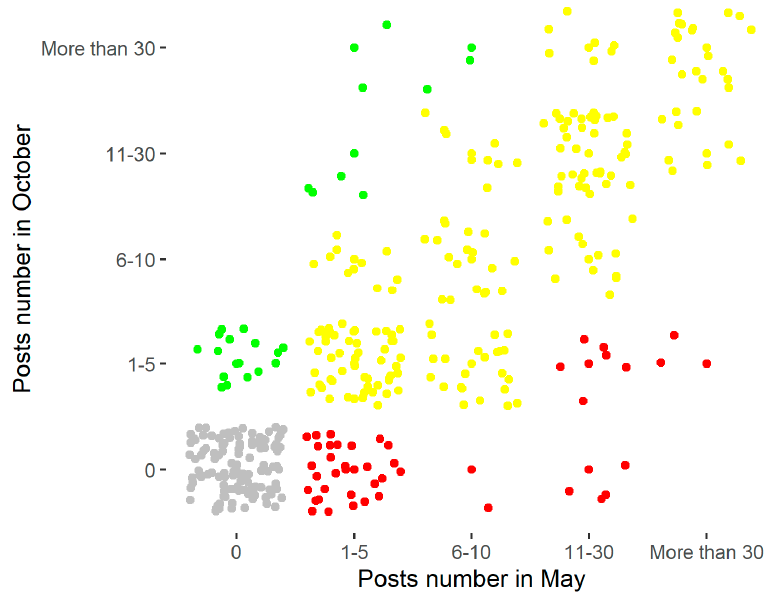
Figure 5. Scatterplot.